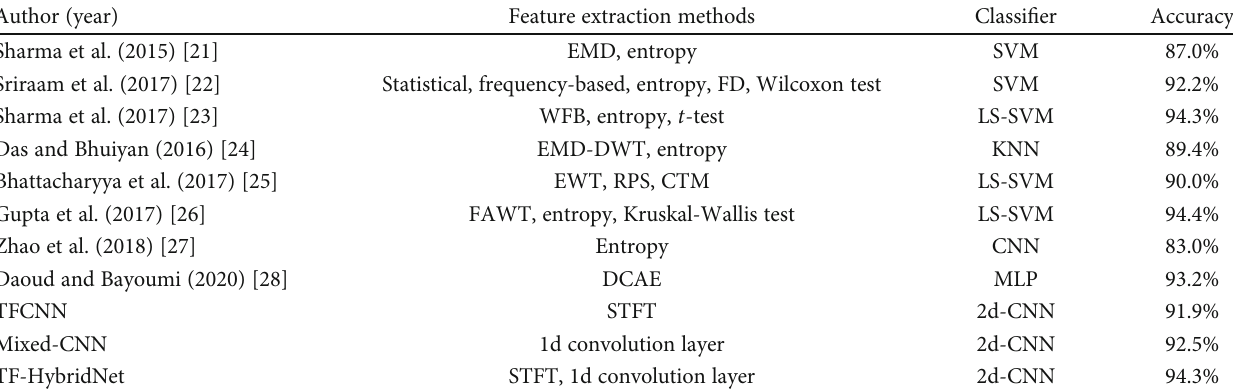
Table 2: Detection results of focal and nonfocal EEG signals of published journal articles using the Bern-Barcelona EEG database. Author